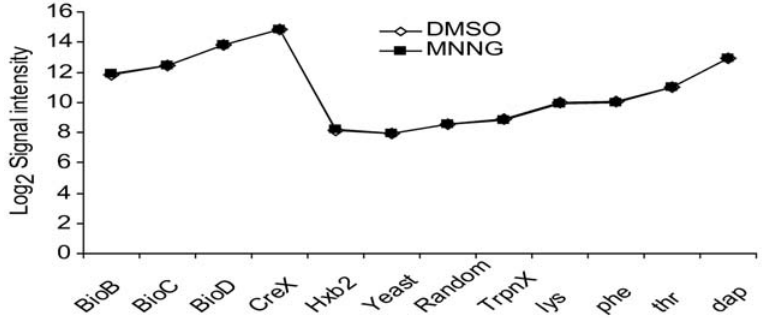
Figure 4. Reference and MNNG treated E.coli control probeset average intensities. Average signal intensities for all control probes in reference (Dimethyl Sulfoxide Reductase (DMSO) added only) and treated (N-methyl-N’-nitro-N-nitrosoguanidine (MNNG)) E. coli . It is easily seen that the lines overlap very well (sometimes one is hidden by the other), and hence the two experiments can easily be compared with only a minor baseline